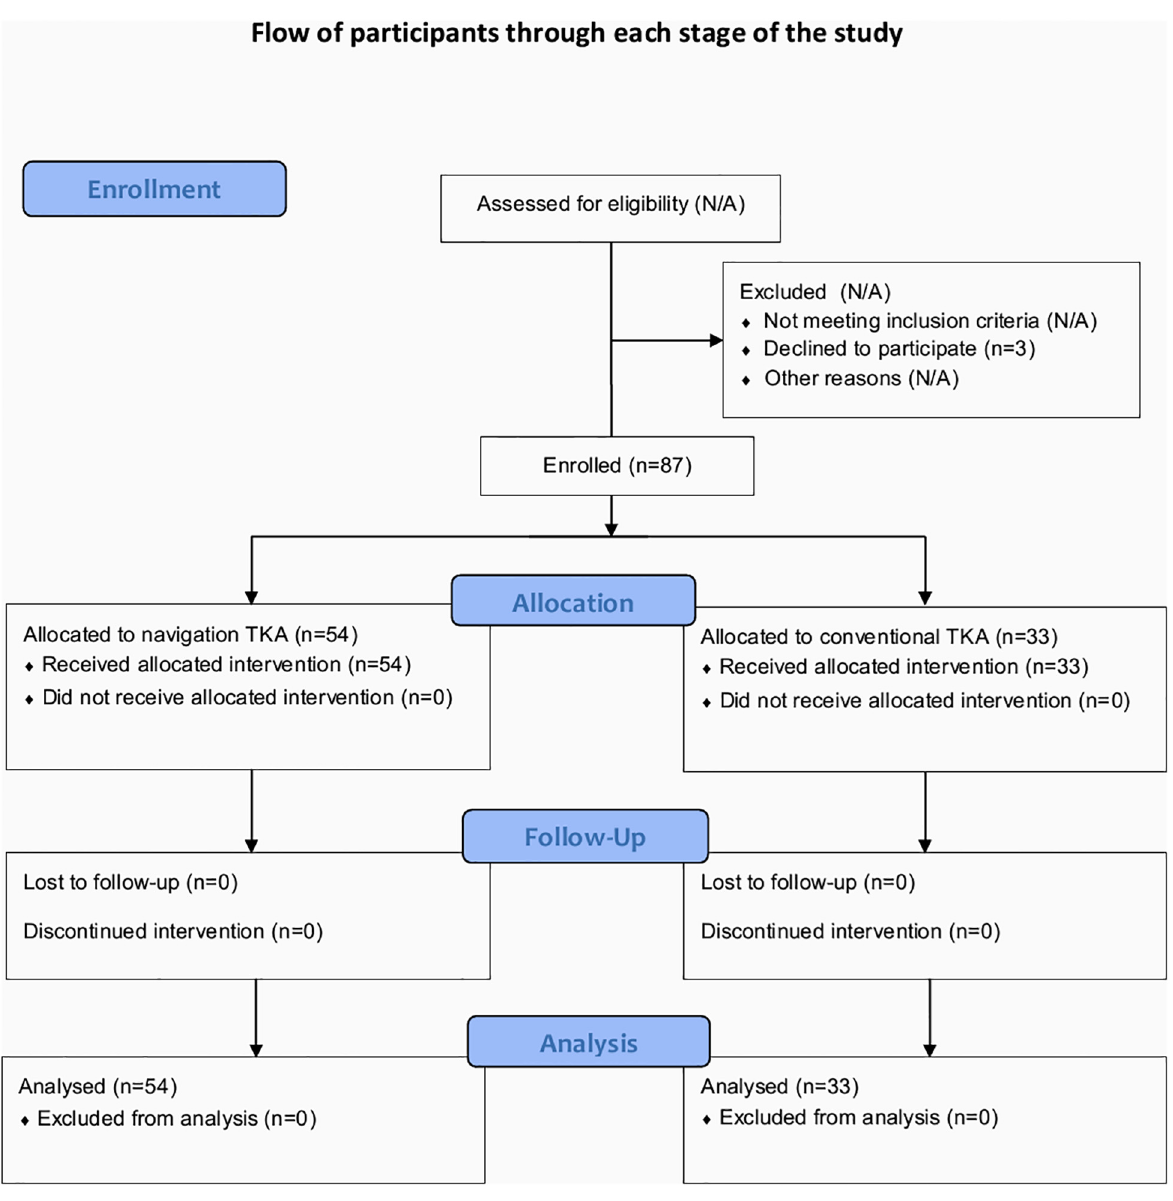
Fig 1. Flowchart of the participants through each stage of the study.